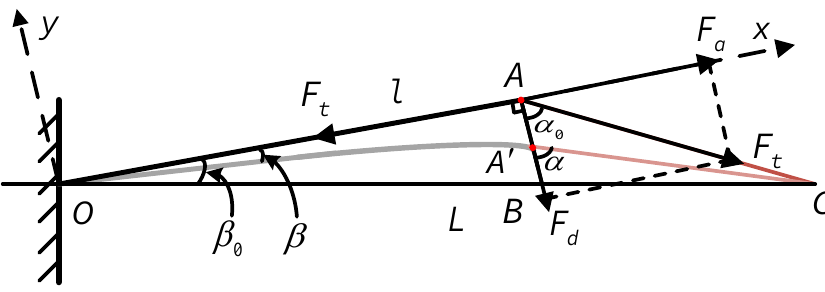
Figure 4. The simplified schematic that the cable tension F t effects on a cantilever of the